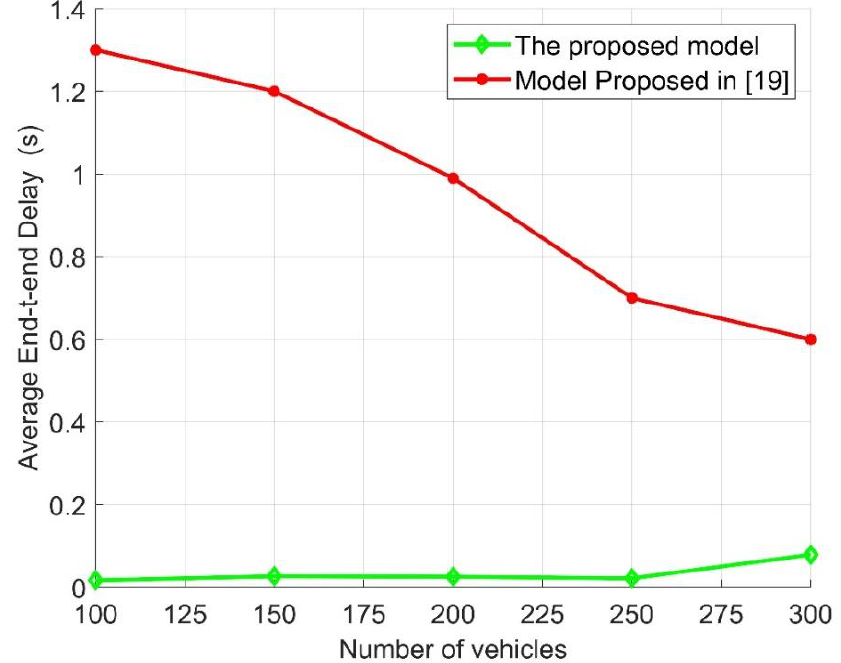
Figure 6. Average end-to-end delay [E2E] versus the number of vehicles.